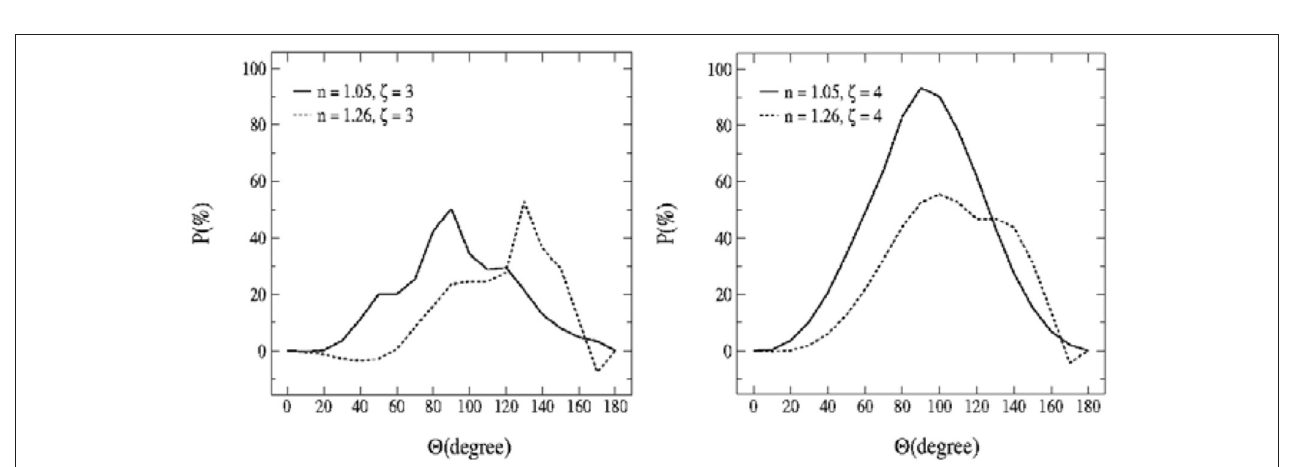
FIGURE 7 | The DoLP (%) [labeled as P(%)] in-water as a function of scattering angle for four different polydisperse assemblages of hydrosols: size distributions with the Junge PSD slope ξ 3 (left) and ξ 4 (right) and particles with low refractive index (organic particles n = = 1.26). Reuse with permission from Loisel et al.